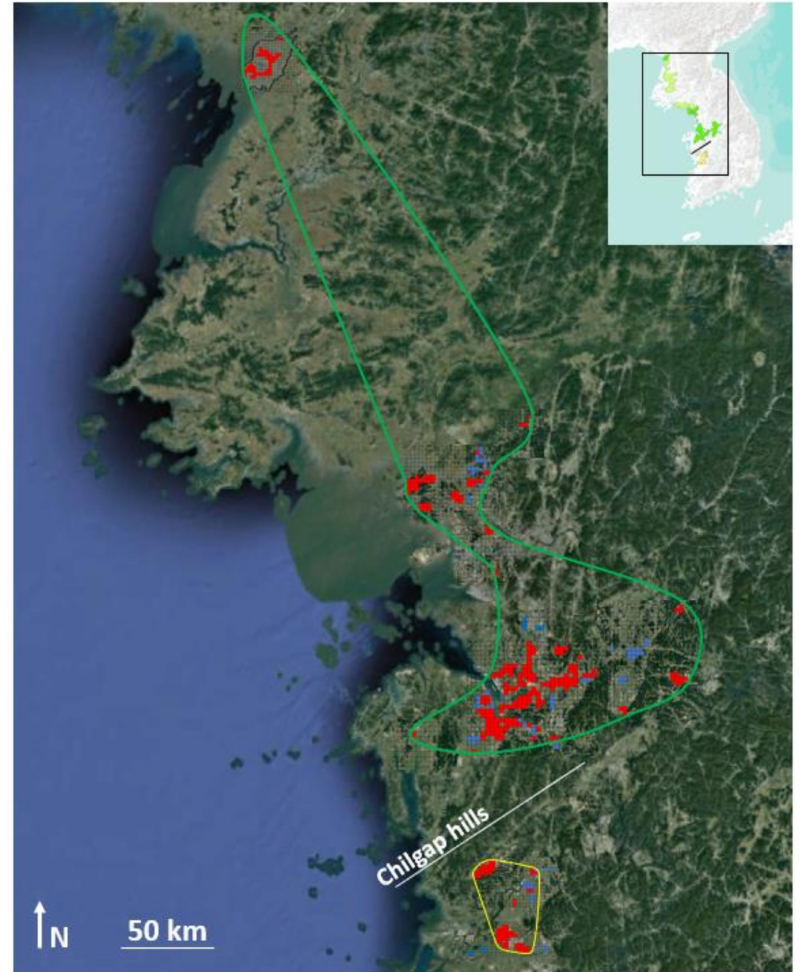
Figure 3. Map for the area of occupancy (AOO) for D. suweonensis and D. flaviventris . Each grid cell is 2 km × 2 km as per the IUCN Red List recommendation; each cell overlapping with a subpopulation is colored in red. Cells in blue represent extirpated subpopulations. Location data extracted from [96] (Chapter 2). Map data © 2020